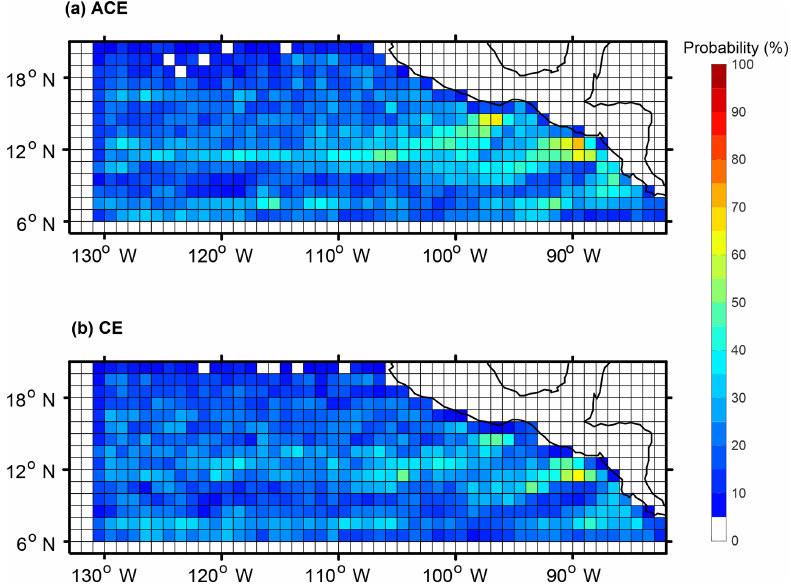
Figure 5. Spatial distribution of the probability of eddy occurrence in bins of 1 ◦ × 1 ◦ resolution for (a) anticyclonic eddies (ACEs) and (b) cyclonic eddies